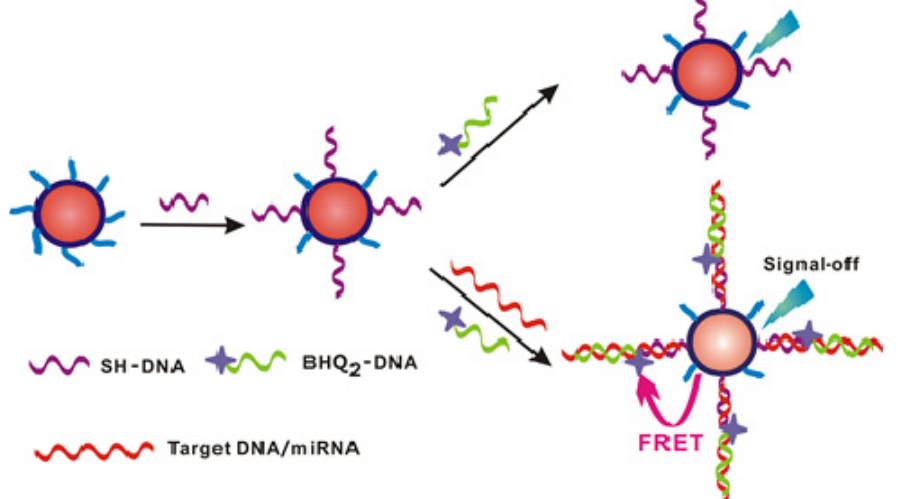
Figure 6. Schematic representation of the designed nanosensors for detection of DNA/miRNA based on the FRET system. Reprinted with permission from [45]. Copyright 2012 American Chemical Society.